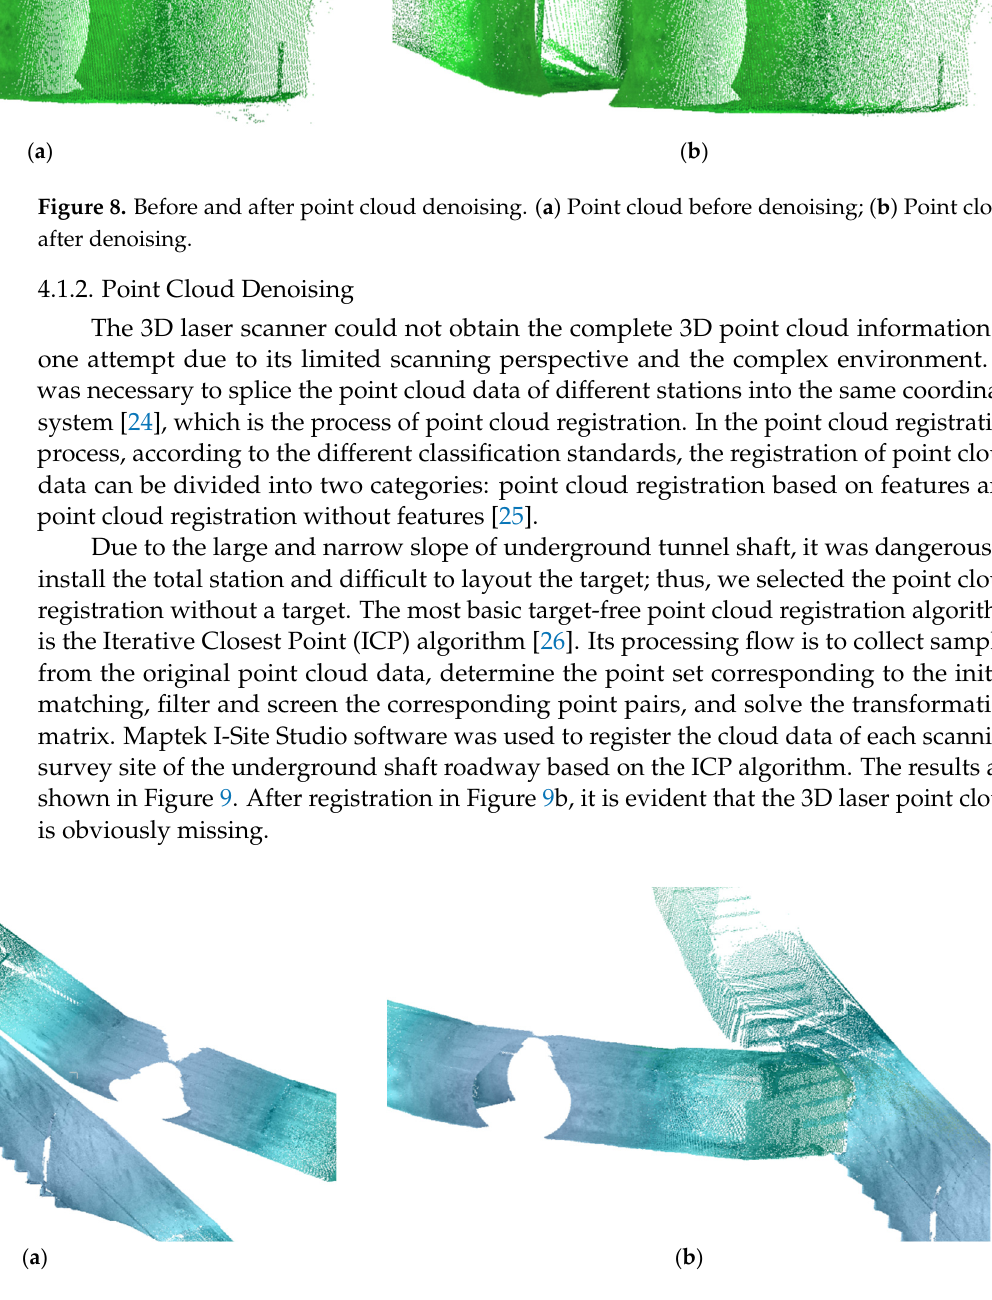
Figure 9. Before and after 3D laser point cloud registration. ( a ) Point cloud before registration; ( b ) Point cloud after registration.